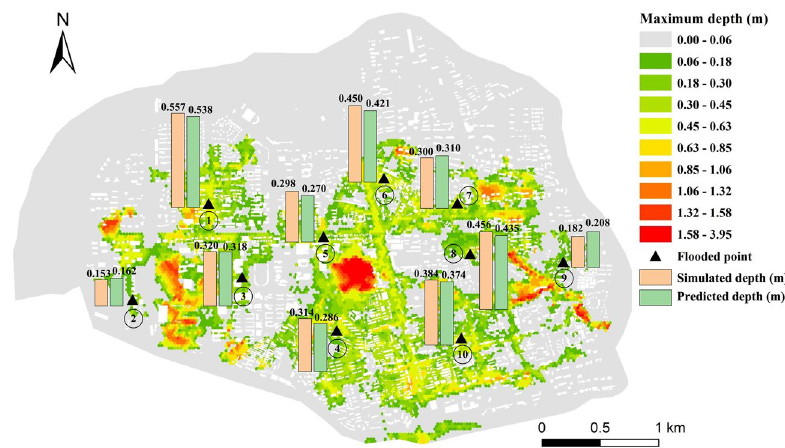
Fig. 10 Comparison of simulated water depth from PCSWMM with predicted water depth from the light gradient boosting machine (LightGBM) model at flooded points in the Haidian Island study area on Hainan Island, China during Typhoon Rammasun on 18 July 2014